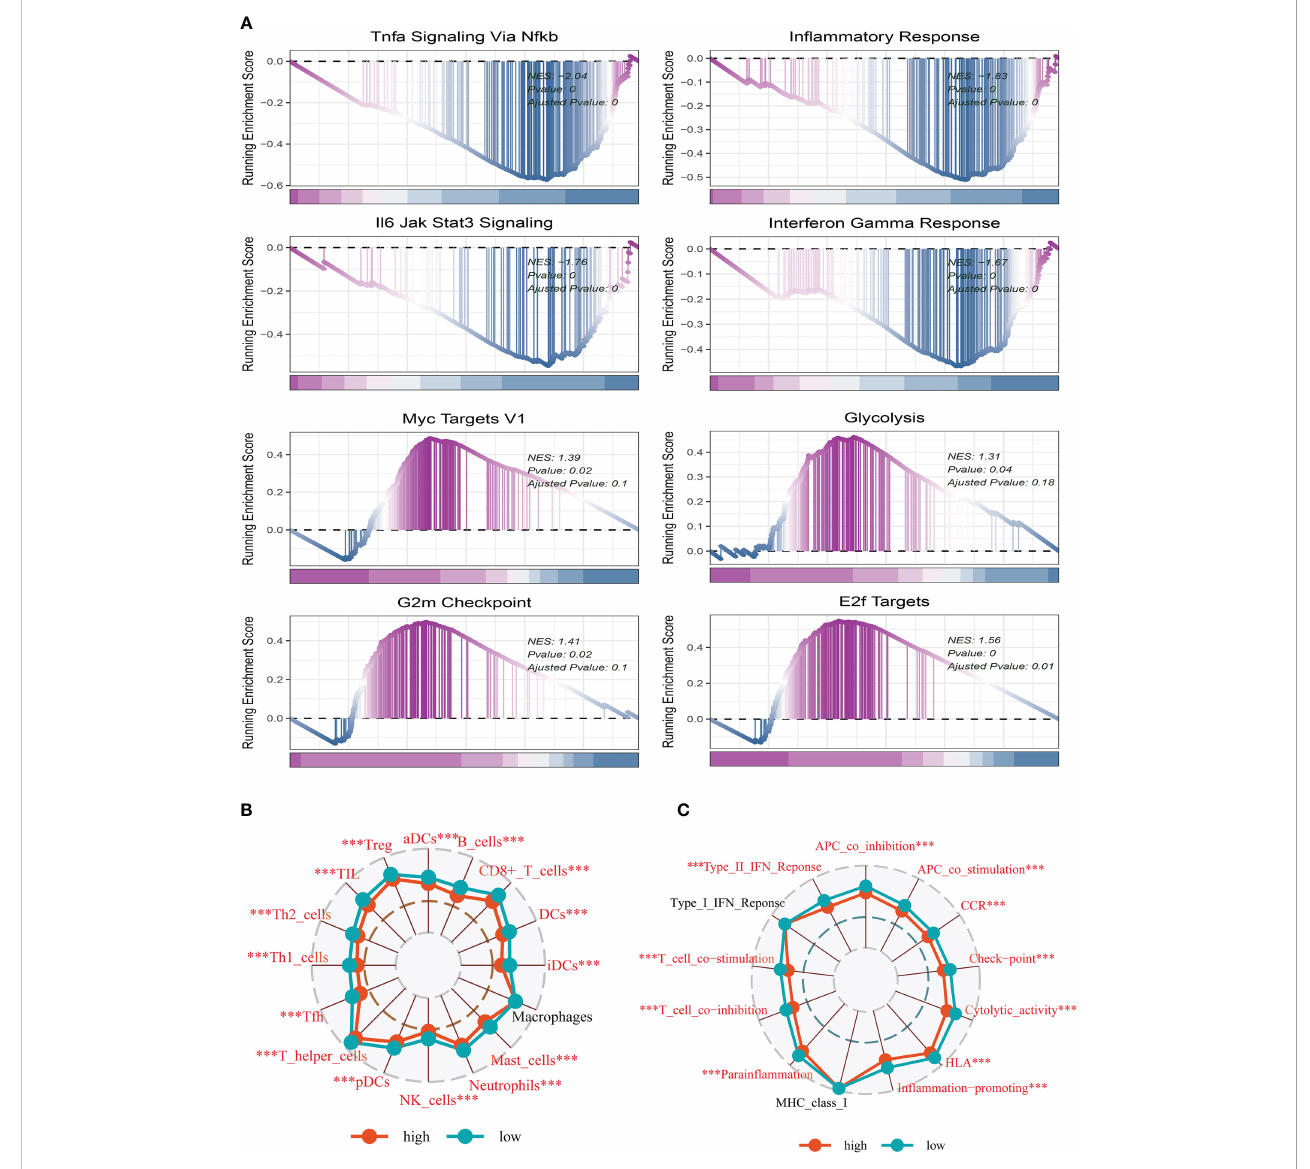
FIGURE 6 Enrichment analysis and functional annotation. (A) GSVA shows the enrichment of hallmark gene sets in different risk subgroups. (B, C) The ssGSEA algorithm was used to evaluate the differences in immune cells and immune-related functions between high- and low-risk subgroups. The *** represents